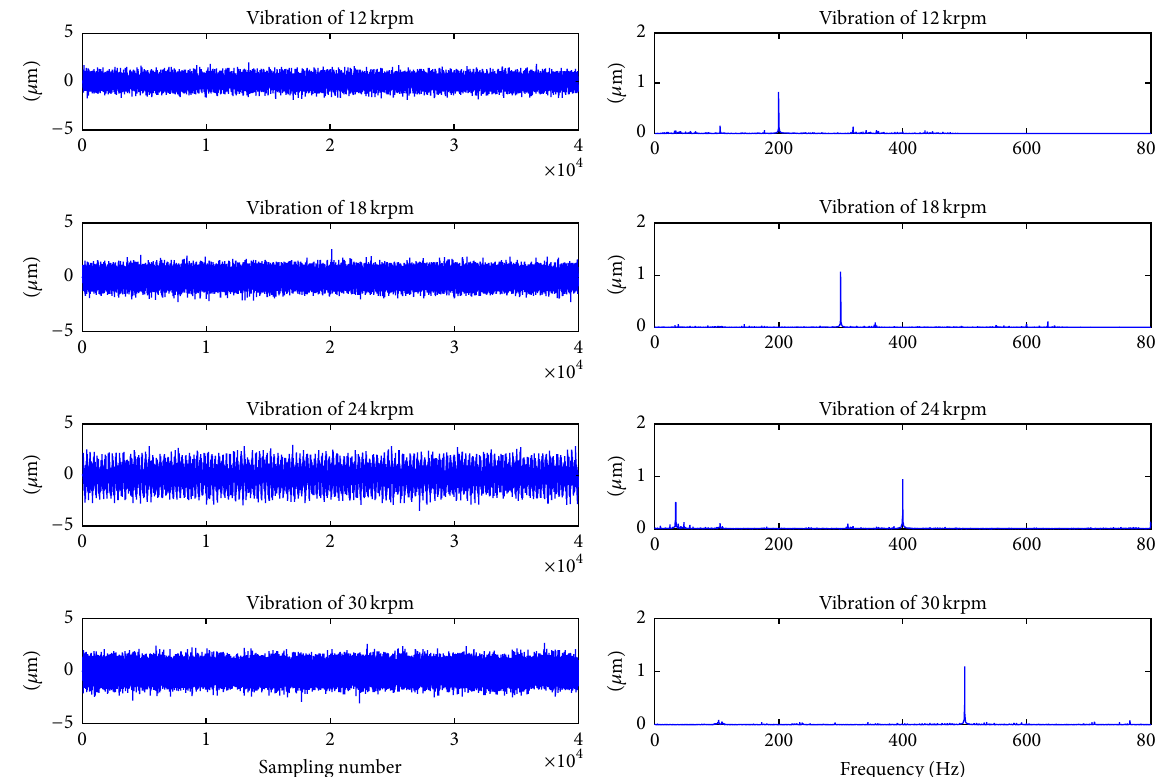
Figure 5: Vibration amplitude versus rotational speed in time domain and frequency